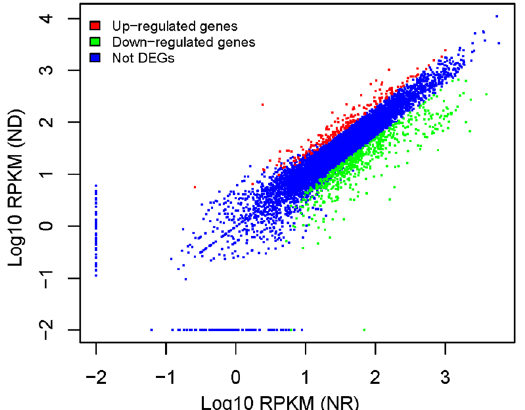
Figure 2. Differentially expressed genes under N repletion (NR) and N deprivation (ND). Distribution of gene expression (log10-transformed RPKM values (reads per kilobase per million mapped reads)) between NR and ND, with the differentially expressed genes highlighted. The colors represent different probability values. The darker regions represent a higher gene